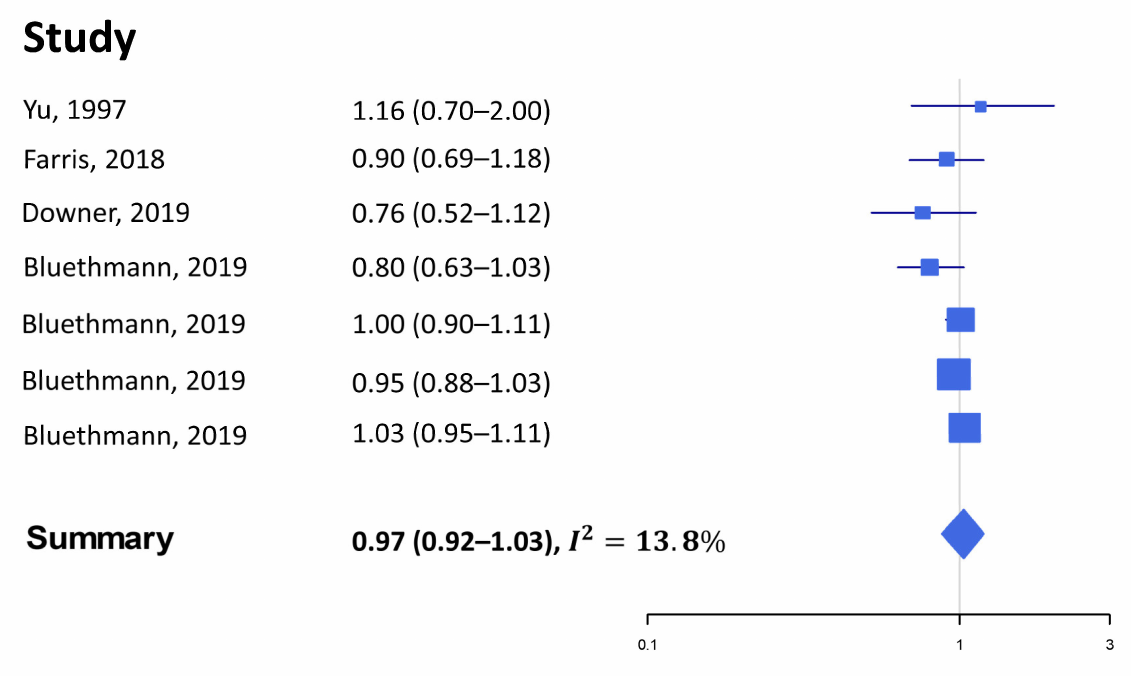
Figure 4. Forest plot of the measures of association between alcohol intake (highest vs. lowest category) and the overall survival of prostate cancer patients [13,37,41,42]. The four estimates from Bluethmann refer to four age groups in the following order: 40–54; 55–64; 65–74;